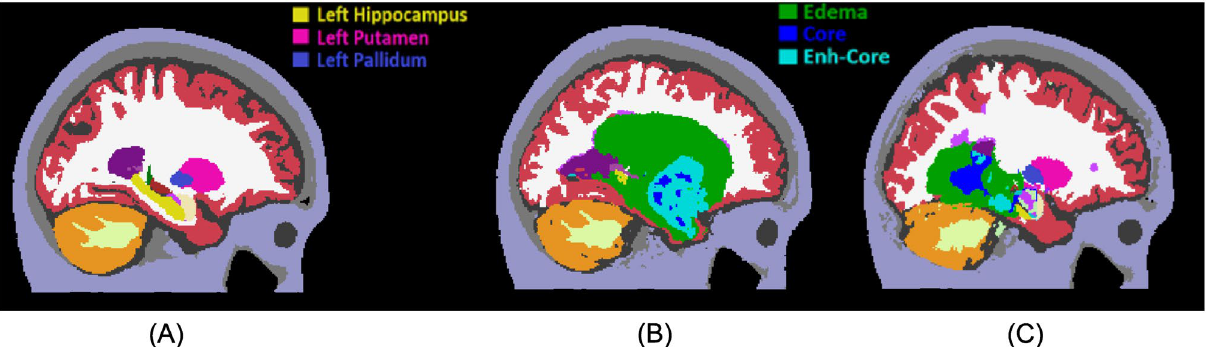
Figure 3. The atlas segmentation reflecting average anatomy ( A ) and automatic brain segmentations of two subjects with glioblastoma ( B , C ). The subject in ( B ) has a highly deformed left hippocampus, pallidum, and putamen, which is reflected in high Hd95 values for these structures. While the hippocampus in ( C ) is also deformed, the pallidum and putamen are largely